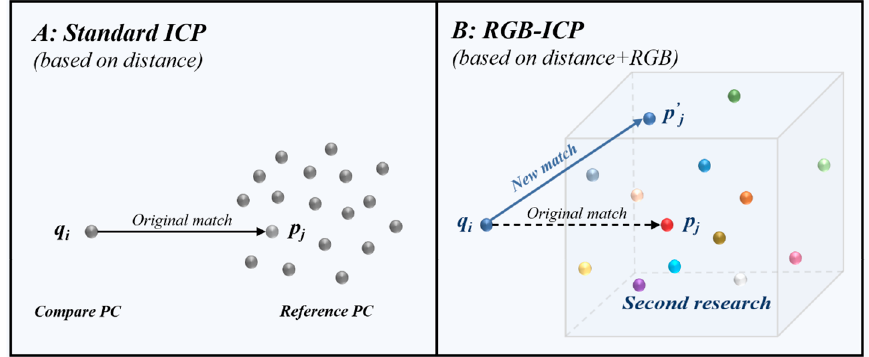
Figure 1. Schematic diagram of the process of matching point pairs using the ICP algorithm (( A ) standard ICP; ( B ) RGB-ICP).